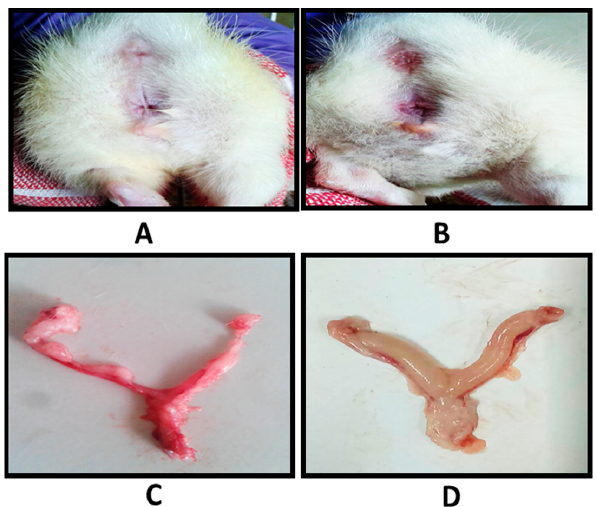
Figure 11. Macroscopic observations of vaginal openings of ( A ) probiotic-loaded suppository treatment group; ( B ) Candida-infected group; the isolated reproductive tracts of ( C ) probiotic-loaded suppository treatment group at day 7, showing healthy pink tissue, and ( D ) Candida infected group with no treatment, showing inflamed tissue.